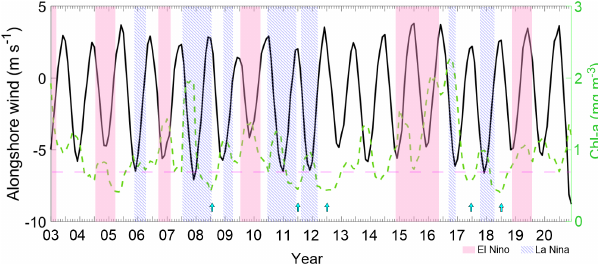
Figure 12. Time series of Chl a (green curve) and along-shelf wind (black curve). Stripes point out the El Niño (magenta) and La Niña (blue) events. The blue with black arrows point out the minima value of Chl a concentration. The dashed magenta lines indicate high Chl a concentrations during El Niño